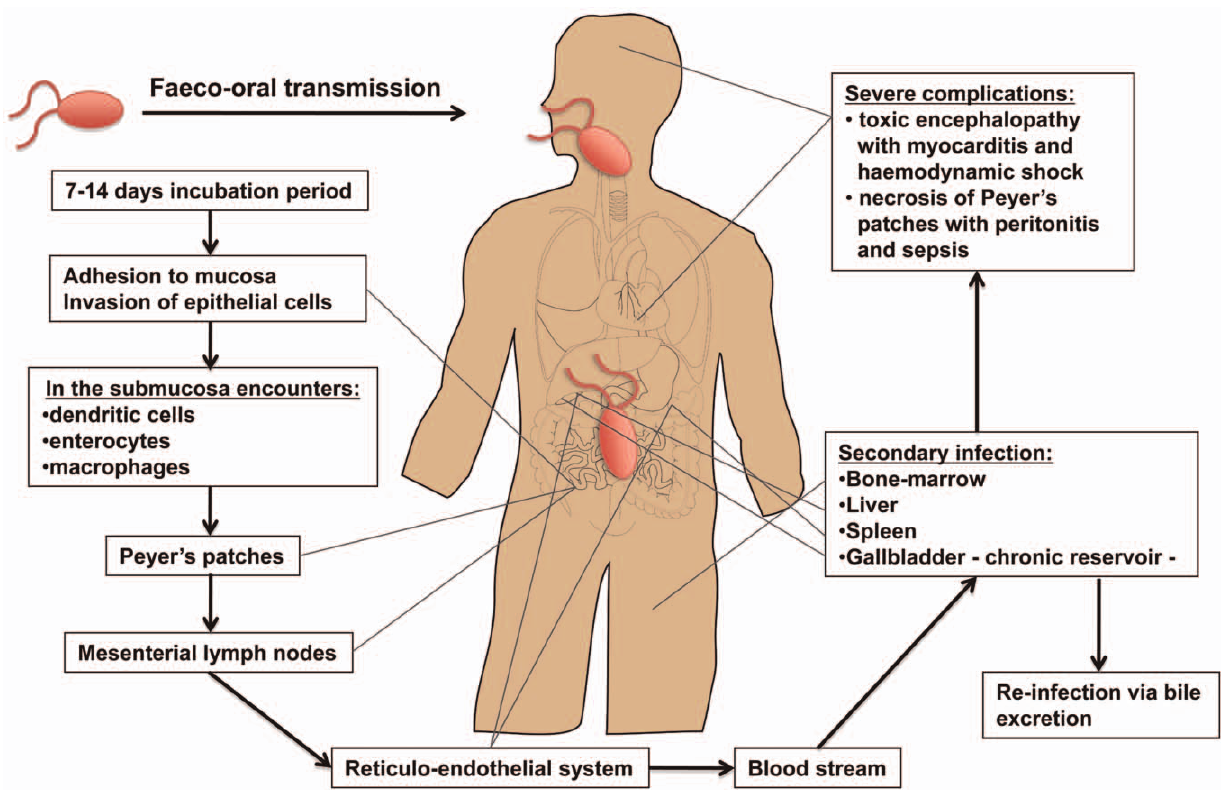
Figure 1. Dissemination of S. Typhi during systemic infection. Typhoid is usually contracted by ingestion of food or water contaminated by fecal or urinary carriers excreting S. Typhi. The incubation period is usually 7 to 14 d. In the small intestine the bacteria adhere to the mucosa and then invade the epithelial cells. The Peyer’s patches, which are aggregrated lymphoid nodules of the terminal ileum, play an important role in the transport to the underlying lymphoid tissue. Specialized epithelial cells such as M cells overlying these Peyer’s patches are probably the site of internalization of S. Typhi. Once the bacteria have penetrated the mucosal barrier, the invading organism translocates to the intestinal lymphoid follicles and the draining mesenteric lymph nodes, and some pass on to the reticuloendothelial cells of the liver and spleen. During the bacteremic phase, the bacteria are widely disseminated throughout the body. Secondary infection can occur with liver, spleen, bone-marrow, gallbladder, and Peyer’s patches as the most preferred sites. The gallbladder is the main reservoir during a chronic infection with S. Typhi and invasion occurs either directly from the blood or by retrograde spread from the bile. Of interest, the ability of Salmonella to form biofilms on gallstones is likely to be a critical factor in establishment of chronic carriage and shedding of S. Typhi [88]. The bacteria that are excreted in the bile can then reinvade the intestinal wall by the mechanism previously described or are excreted by feces. Typical clinical symptoms are fever, malaise, and abdominal discomfort. Clinical features such as a tender abdomen, hepatomegaly, splenomegaly, and a relative bradycardia are common. Rose spots, the classical skin lesions associated with typhoid fever, are relatively uncommon and occur in 5%–30% of cases. The most severe manifestations of typhoid leading to sepsis and death are either necrosis of the Peyer’s patches resulting in gut perforation and peritonitis or a toxic encephalopathy associated with myocarditis and haemodynamic shock [8,89].